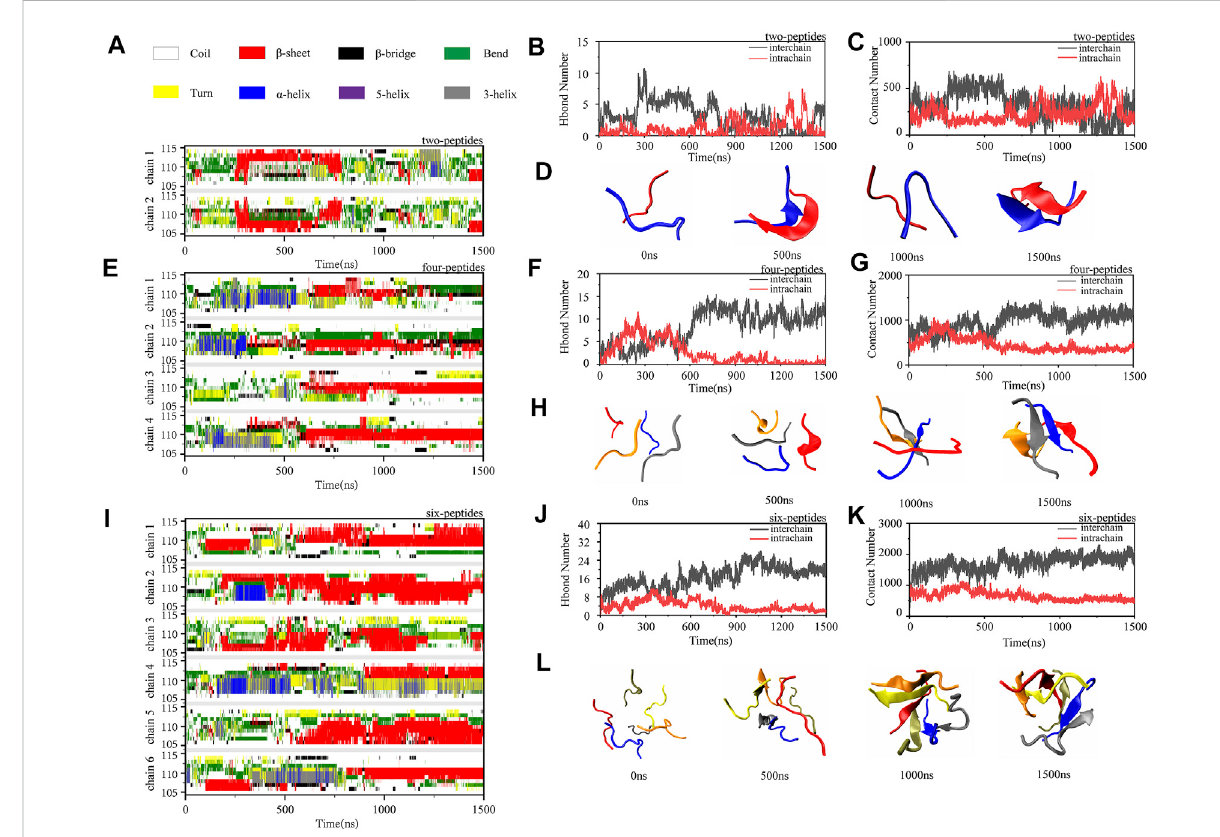
FIGURE 3 Oligomerization and fi brillization dynamics of TTR (105 – 115) aggregation. (A,E,I) The time evolution of secondary structure for each residue of the two-, four- and six-peptides systems. (B,C,F,G,J,K) The number of intrachain and interchain backbone hydrogen bonds and contacts are presented as the function of simulation time for the two-, four-, and six-peptides systems. (D,H,L) The structures of two-, four-, and six-peptides were